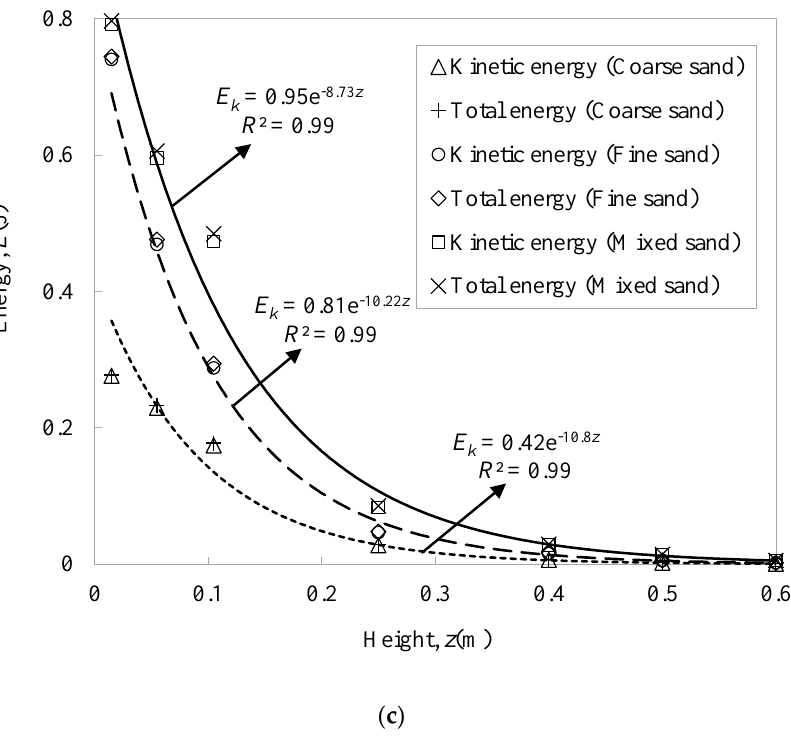
Figure 14. The energy distribution: ( a ) At the indicated wind speed of 14.74 m/s; ( b ) At the indicated wind speed of 16.68 m/s; ( c ) At the indicated wind speed of 18.61 m/s.